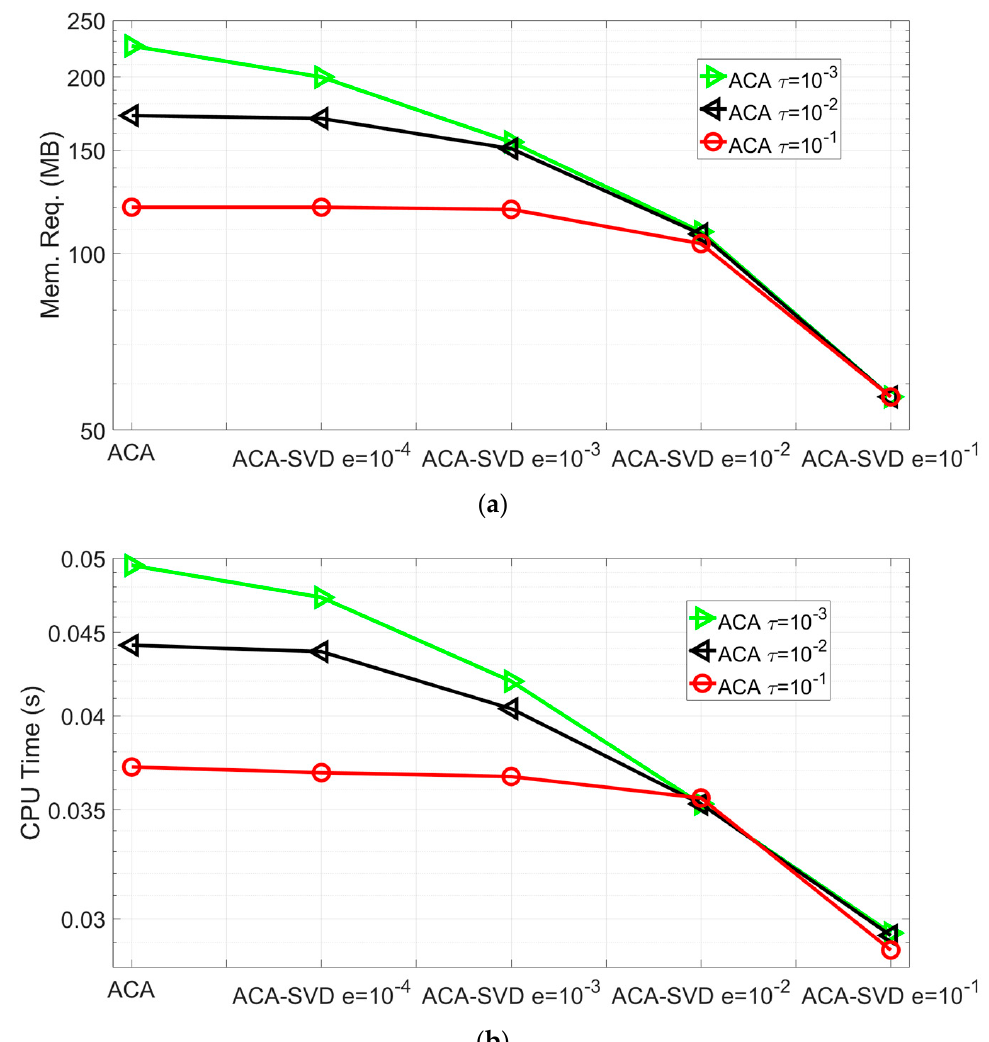
Figure 3. Performance of ACA-SVD based BEM forward solver for predicting the impedance vari- ations of placing coil C27 above conducting plate B2 with ACA tolerance τ = 10 − 1 ,10 − 2 ,10 − 3 and SVD truncated error e = 10 − 1 ,10 − 2 ,10 − 3 ,10 − 4 . ( a ) The memory requirements of the far block interactions. ( b ) CPU time per iteration. Table 4. Impedance variations predicted by ACA-SVD based BEM, analytical, semi-analytical meth- ods and experiments for placing coil C5 above conducting plate B1.